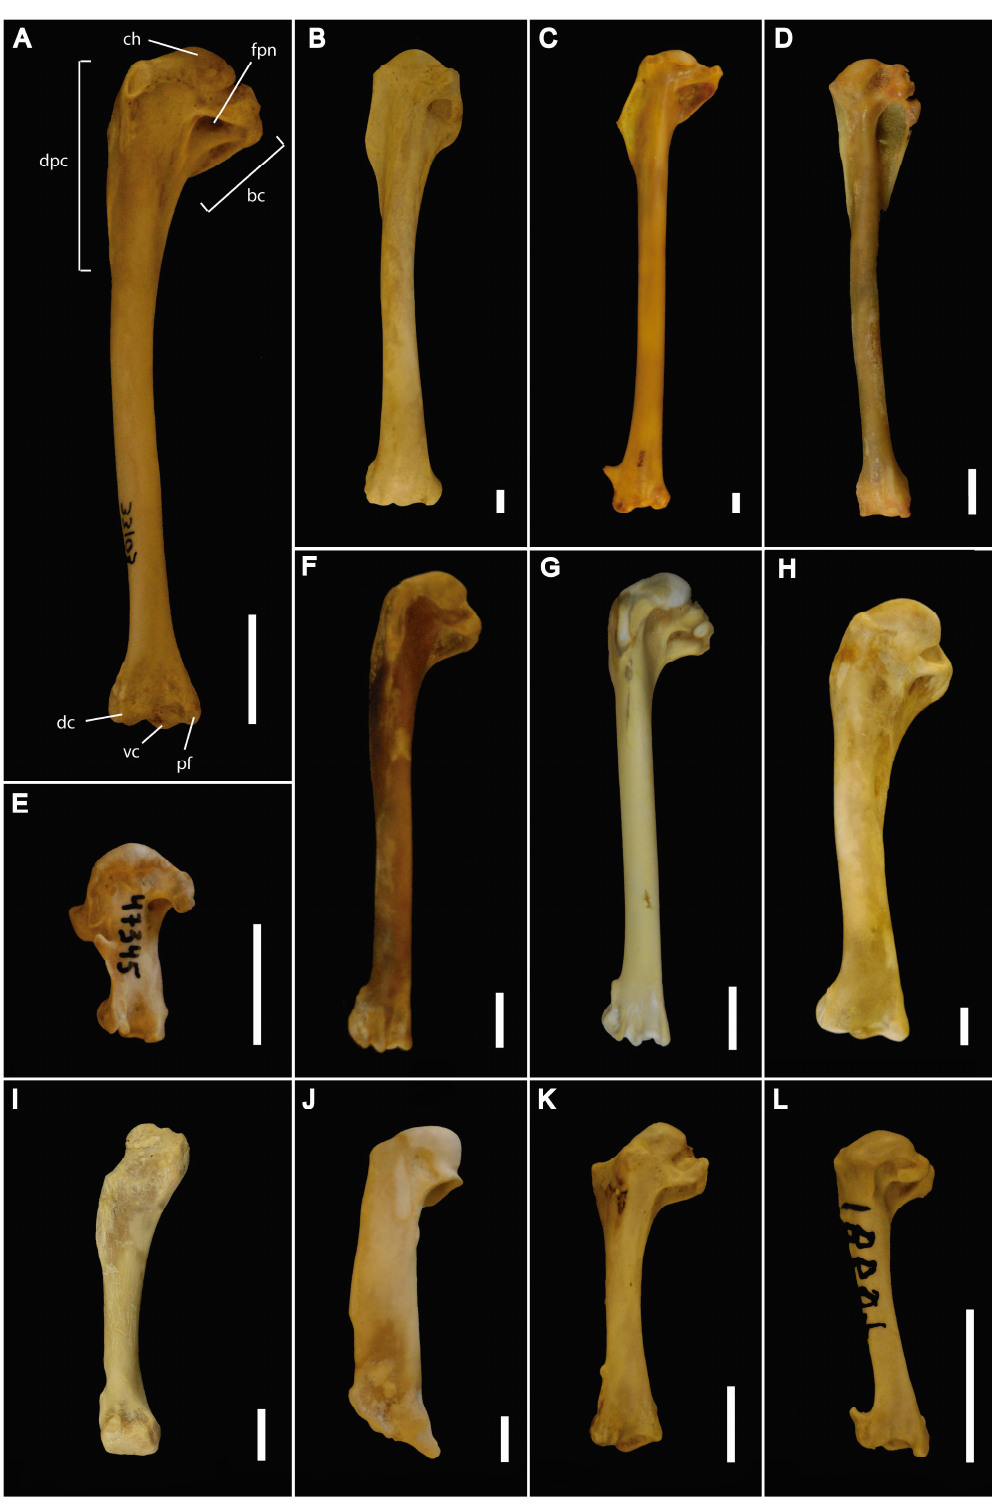
Figure 1. Humeri in caudal view for selected taxa. ( A ) Oxyura jamaicensis UWBM 33103. Abbreviations: bc, bicipitalcrest; ch, caputhumeri; dc, dorsalcondyle; dpc, deltopectoralcrest; fpn, fossapneumotricipital; fp, flexor process; vc, ventral condyle. ( B ) Haliaeetus leucocephalus UWBM 33937. ( C ) Macronectes giganteus UWBM 38048. ( D ) Nannopterum harrisi LACNHM 89910. ( E ) Hirundapus caudacutus UWBM47345. ( F ) Uria aalge UWBM 79468. ( G ) Fratercula corniculata LACNHM 96912. ( H ) Meleagris gallopavo UWBM 59381. ( I ) Casuarius bennetti LACNHM 107030. ( J ) Spheniscus humboldti UWBM 81776. ( K ) Columba rupestris UWBM 59986. ( L ) Cinclus mexicanus UWBM 50254. Scale bars equate to 10